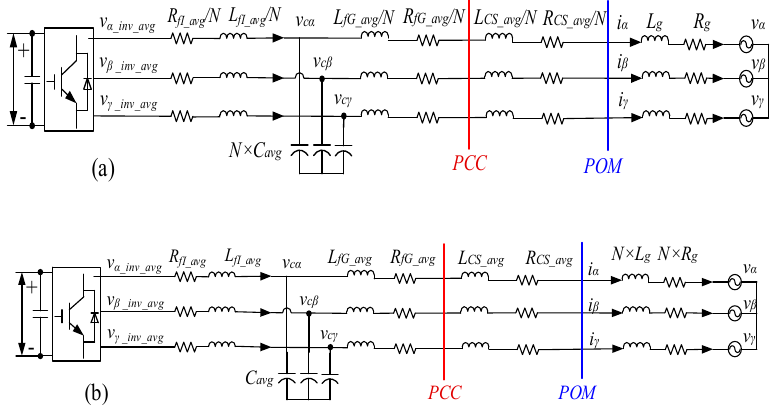
Figure 7. Equivalent circuit diagram of an IBR plant: ( a ) looking from the IBR side, ( b ) looking from the average IBR viewpoint.